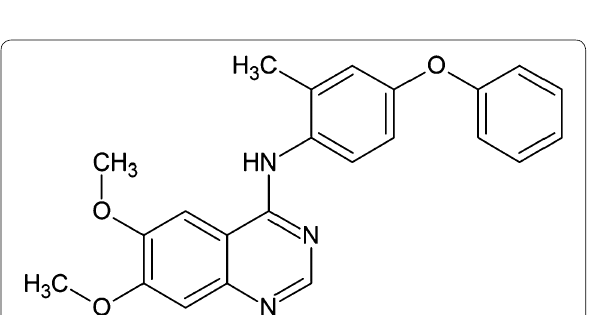
Fig. 2 Chemical structure of APS-2-79, a quinazoline heterocycle and side group of biphenyl ether with attached methyl group [14]. (This figure is republished with permission from both the Nature Publish- ing Group and Dr. Arvin